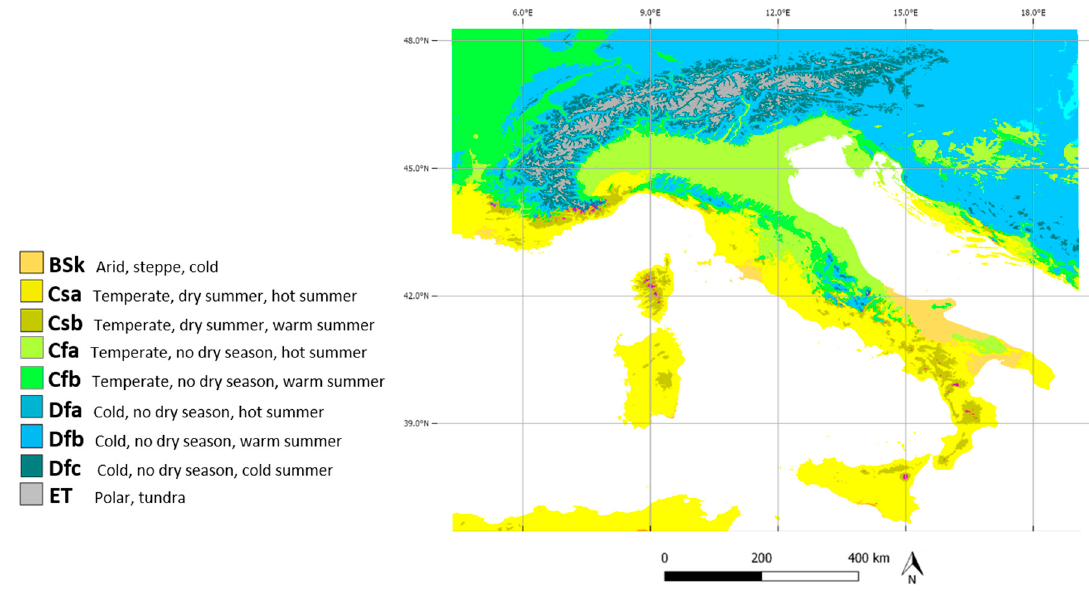
Figure 2. Climate map according to the Köppen–Geiger classification.